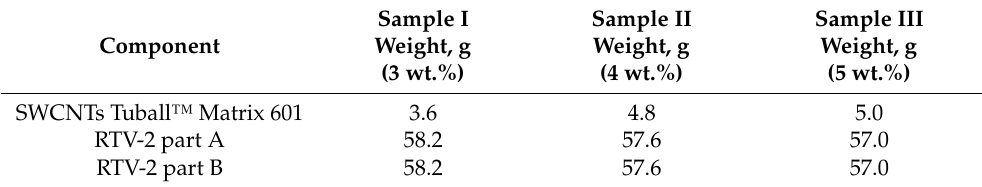
Table 2. Nanocomposite 3,4,5 wt.% Tuball™ Matrix 601 sample preparation (120 g).